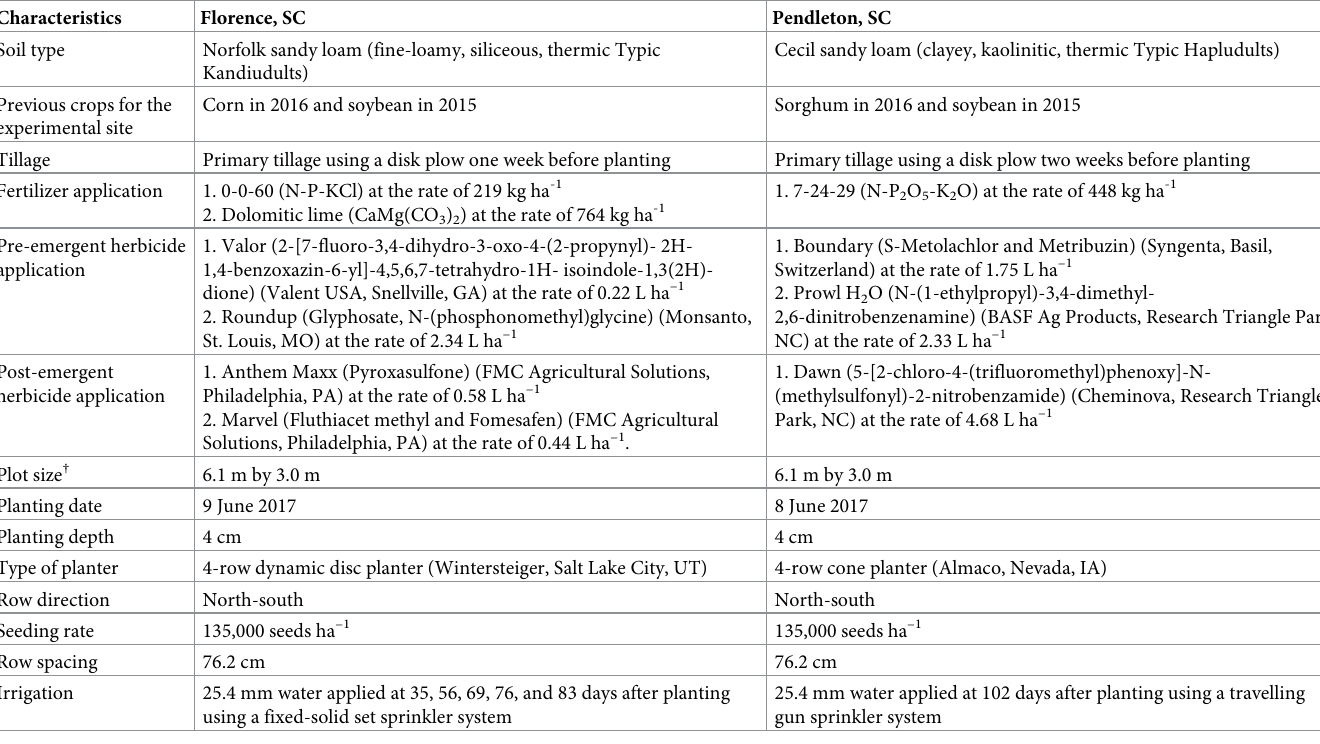
Table 2. The characteristics of the experimental sites and field operations at Florence, SC, USA and Pendleton, SC, USA.